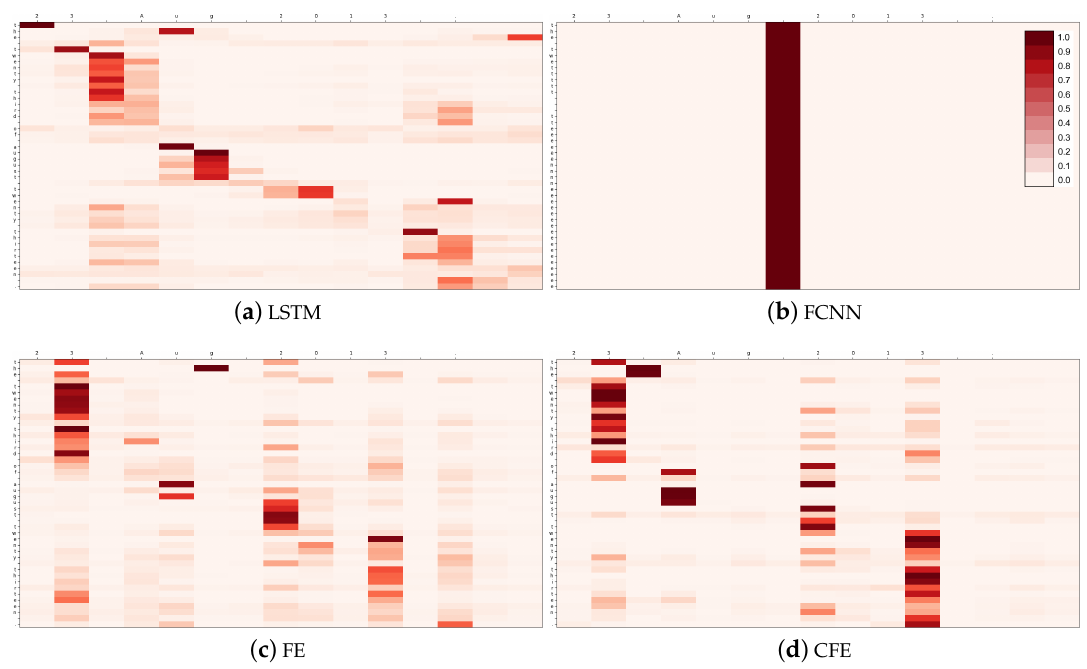
Figure 12. Attention matrices obtained by the four models for the sample selected from E1, shown in Table 9. The input sentence (horizontal axis) is “ 23 Aug 2013 ”. The values represented are the attention coefficients, α (cid:48) (see Equation (2)); a darker color represents a larger value. i